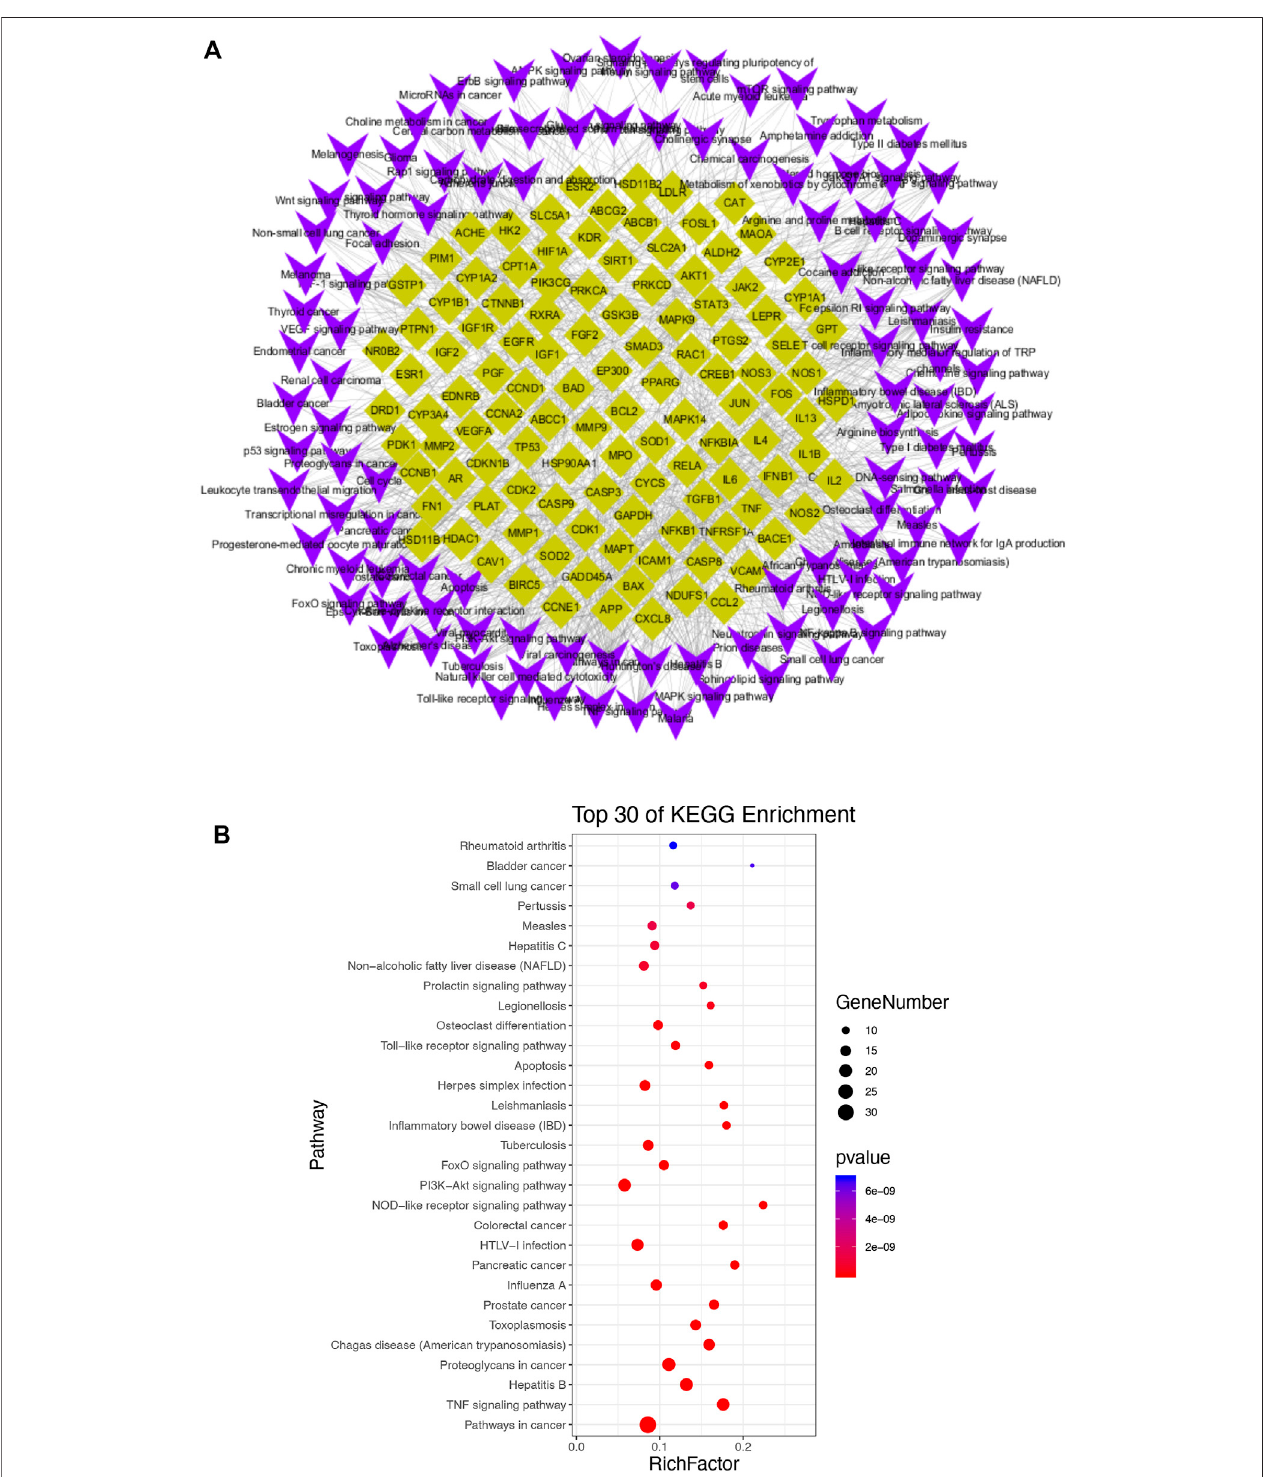
FIGURE 4 | (A) Target – pathway interaction network and (B) KEGG enrichment analysis.